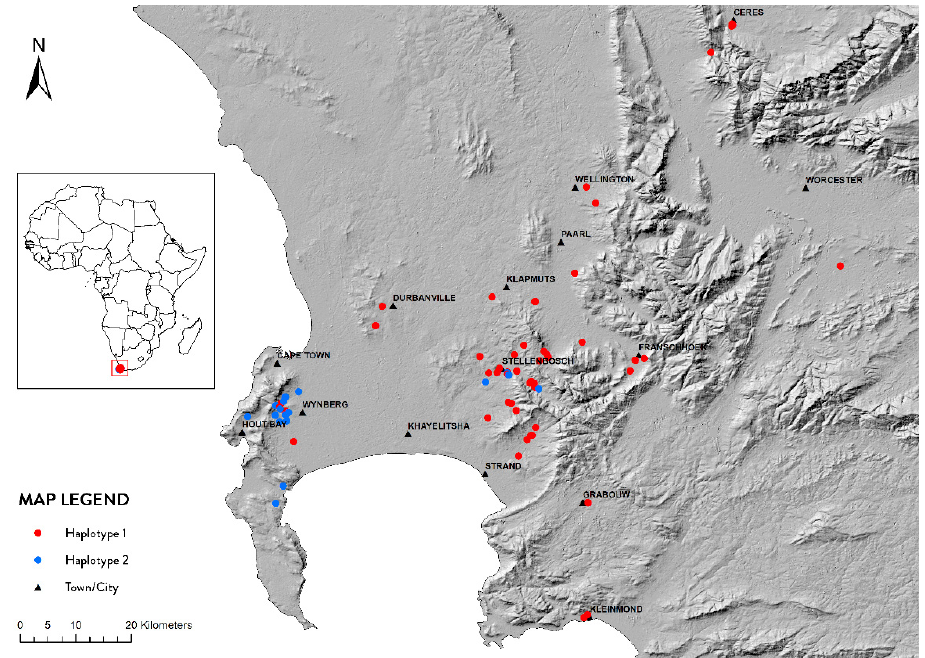
Figure 7. Geographic location of 72 nests of Vespula germanica analyzed in the Western Cape province of South Africa in this study, and the two mitochondrial haplotypes of individual wasps collected from those